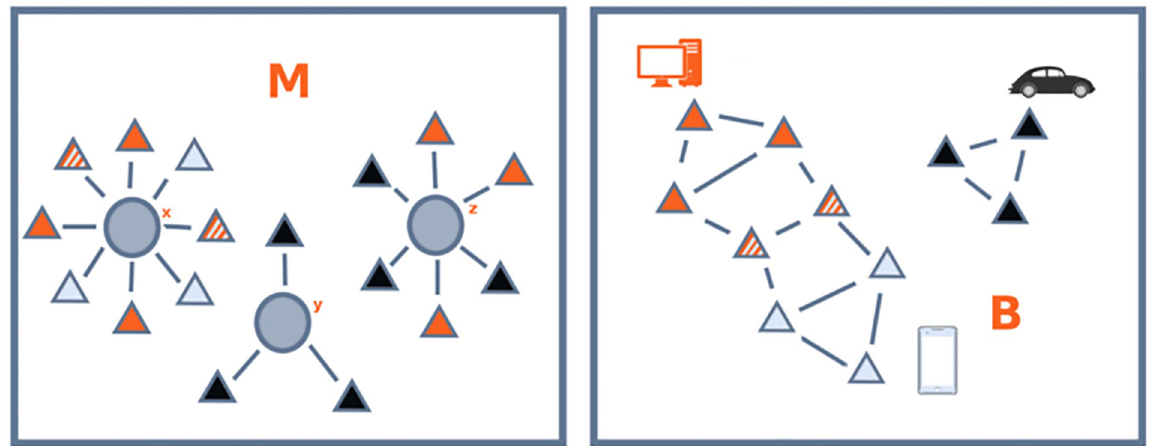
Fig 3. Matrices m and B . Left: the circles represent firms and the triangles represent the technological fields included in their technological portfolios; this is our starting database. Right: the triangular nodes in the graph correspond to a technological fields and are colored to highlight proximity between more frequently co-occurring (and thus more related)